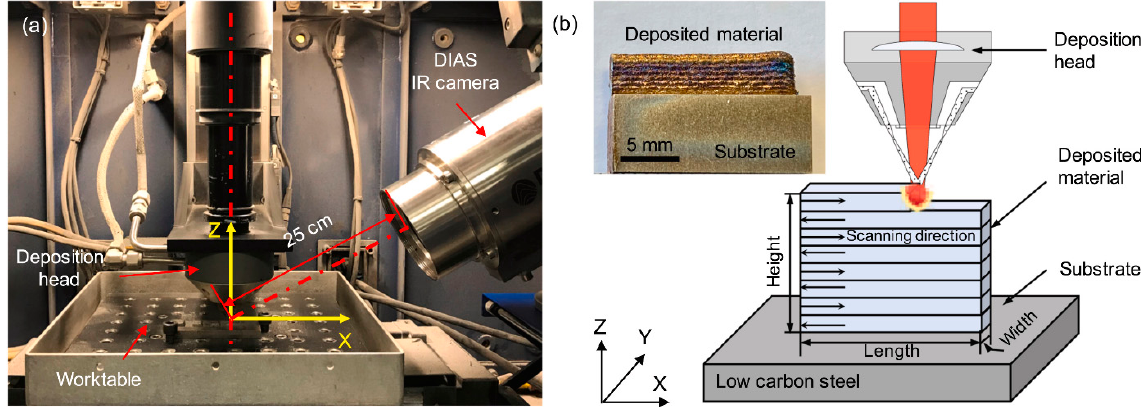
Figure 15. ( a ) The experimental setup and ( b ) the schematics of the laser-engineered net shaping (LENS) process (reprinted with the permission from [78], Elsevier, 2020).